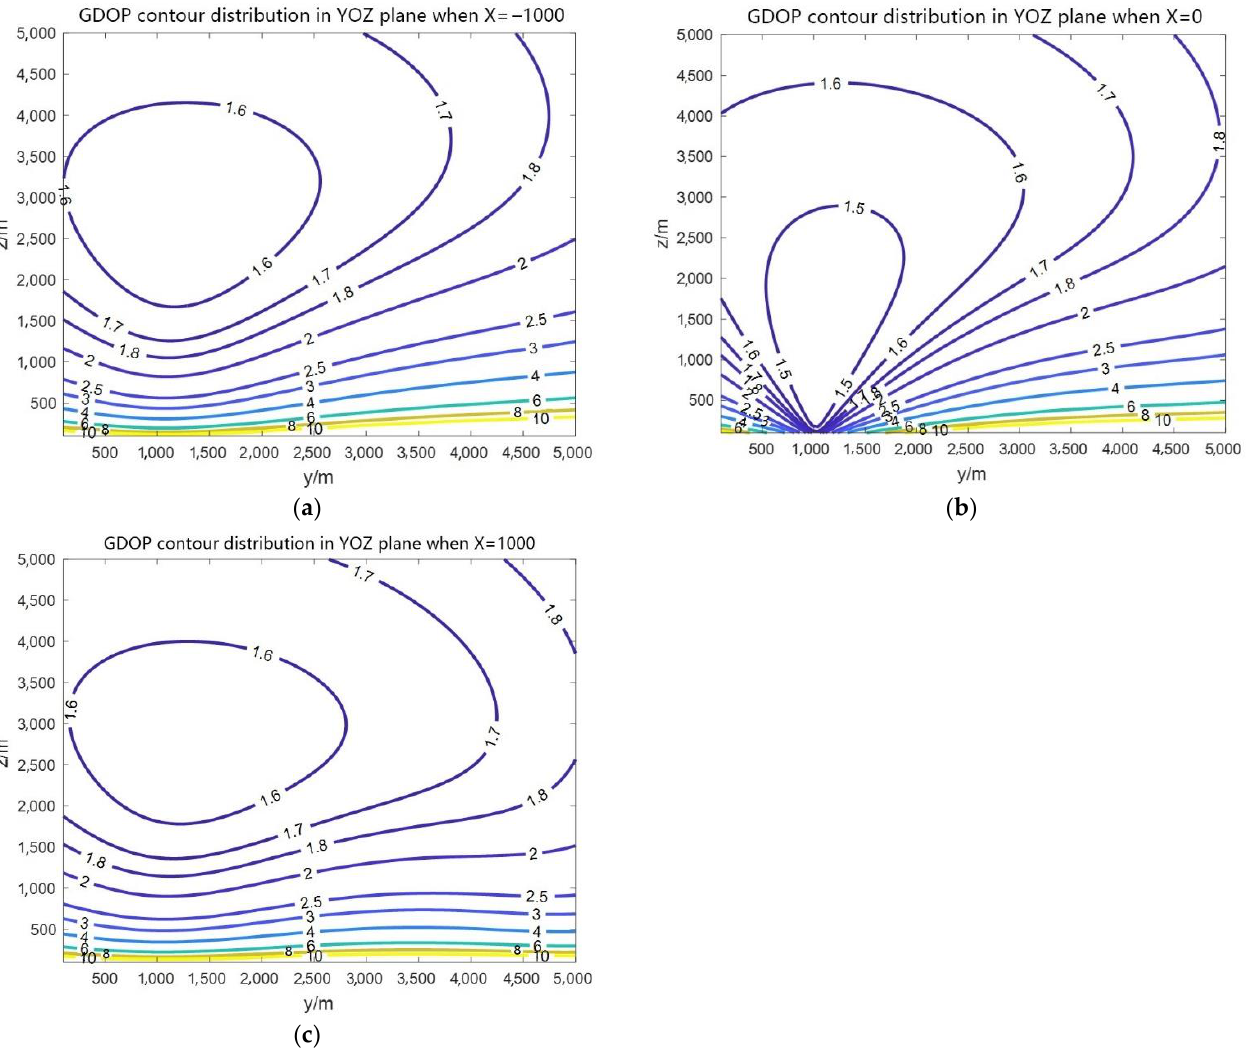
Figure 7. GDOP distribution curve of three YOZ profiles during 1TOA+4TDOA optimized station layout: ( a ) GDOP distribution of YOZ plane when x = − 1 × 10 3 ; ( b ) GDOP distribution of YOZ plane when x =0; ( c ) GDOP distribution of YOZ plane when x = 1 ×10 3 .